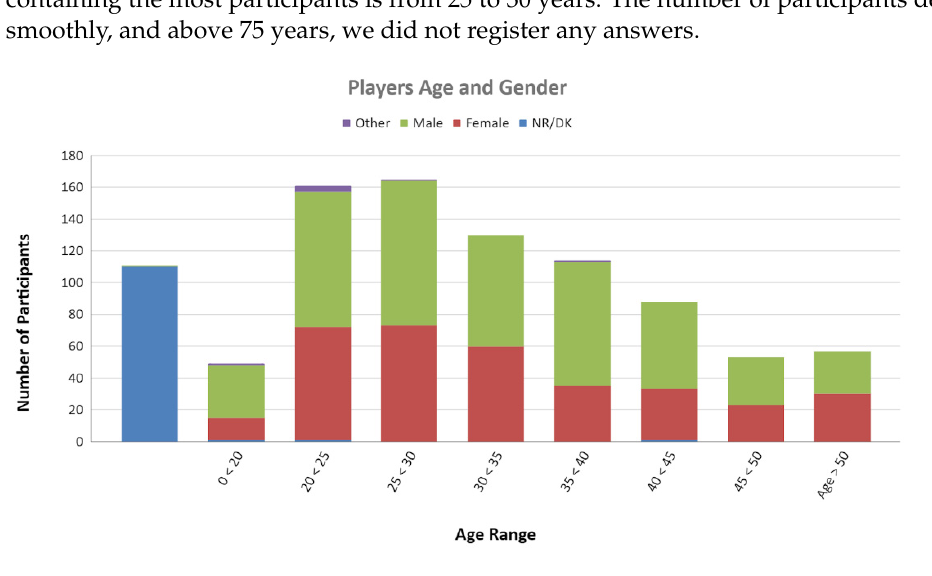
Figure 1. Age and gender of participants in the sample. Source: own elaboration.